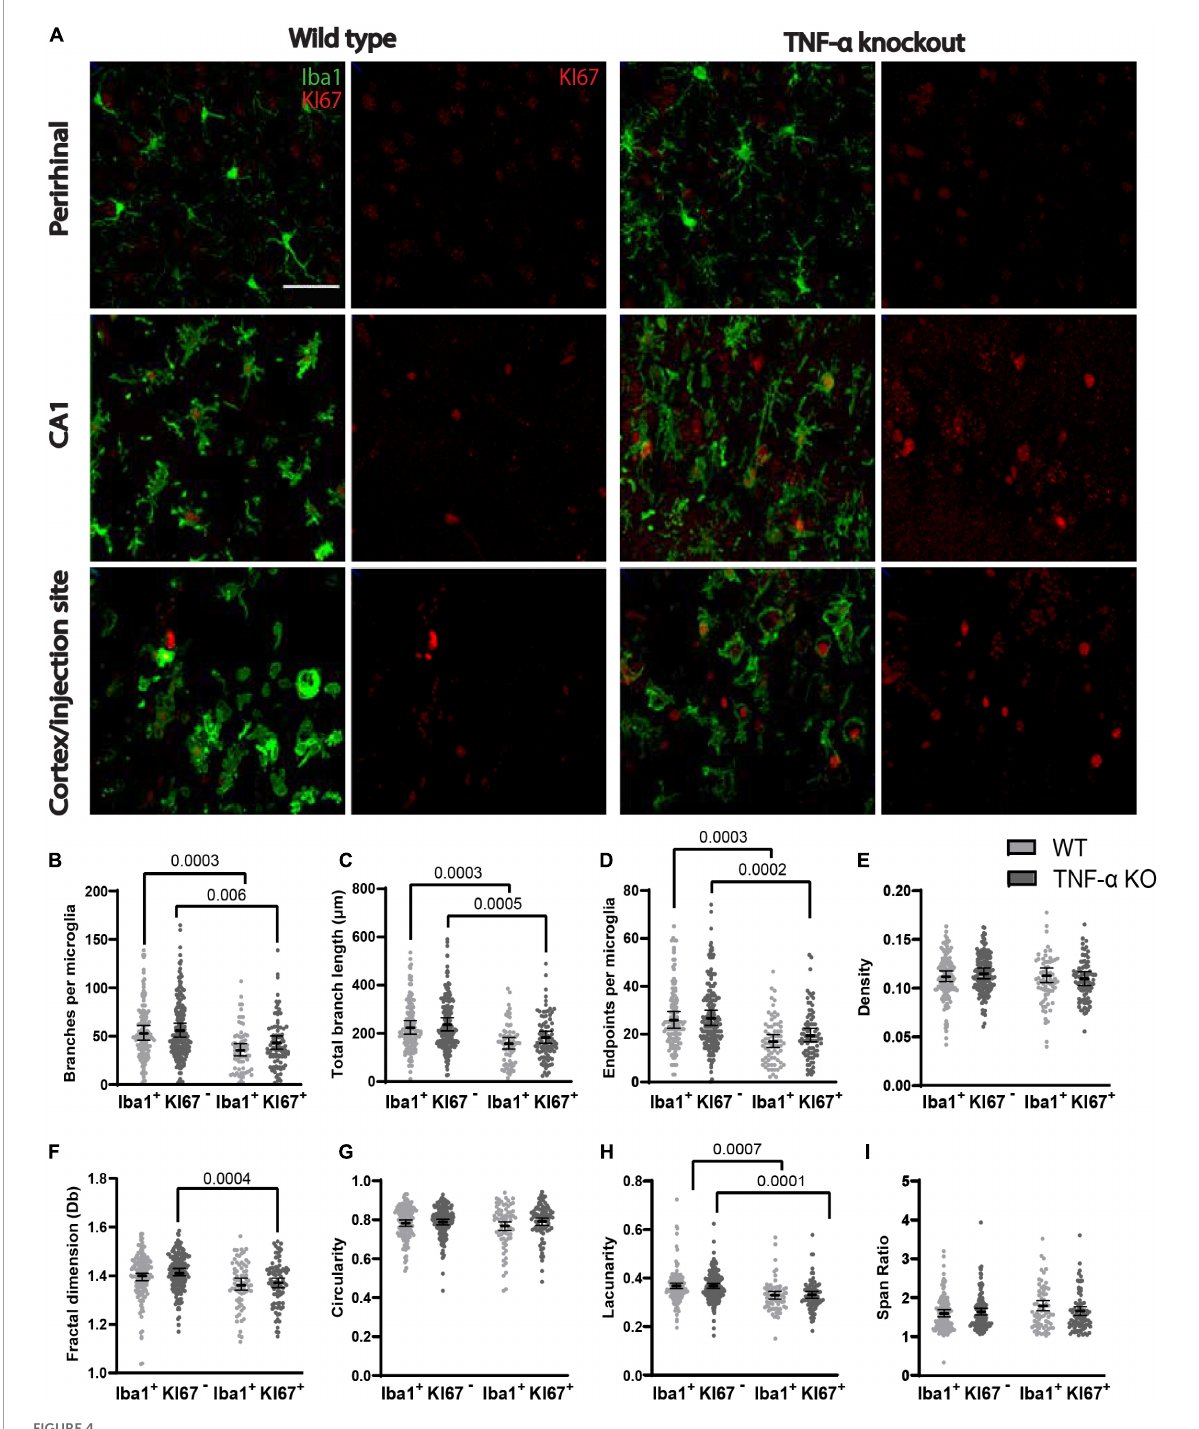
FIGURE4 Dividing (KI67 + ) microglia had less complex, activated morphologies compared to microglia that were not dividing (KI67 − ). (A) Z-stacked photomicrographs of Iba1 (green) stained microglia and KI67 (red) stained dividing cells in the ipsilateral perirhinal cortex, CA1, and cortex/injection site in WT and TNF- α KO mice. (B) Total number of branches per microglia. (C) Total branch length per microglia. (D) Total number of endpoints per microglia. (E) Density of pixels per microglia. (F) Fractal dimension (Db) of microglia. (G) Circularity of microglia. (H) Lacunarity of microglia. (I) Span ratio of microglia. Individual data points are presented as dots and were analyzed using linear mixed models (see Tables 4 , 5 ). Results are presented as point estimates with 95% confidence intervals. Statistically significant post hoc comparisons are indicated by bars with corresponding p -values. Iba1 + /KI67 + = colocalization of Iba1 and KI67. TNF- α KO KI67 − n = 181 microglia; WT KI67 − n = 139 microglia; TNF- α KO KI67 + n = 87 microglia; WT KI67 + n = 71 microglia. Scale bar = 50 µ